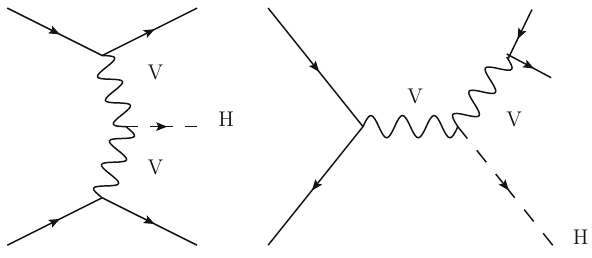
Fig. 1 Representative diagrams for electroweak production of a H + 2 jet final